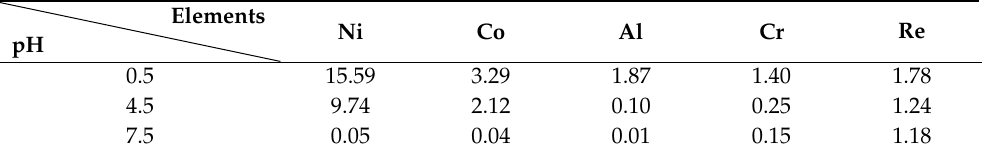
Table 2. Chemical content of the leaching solution at different pH values (g/L).